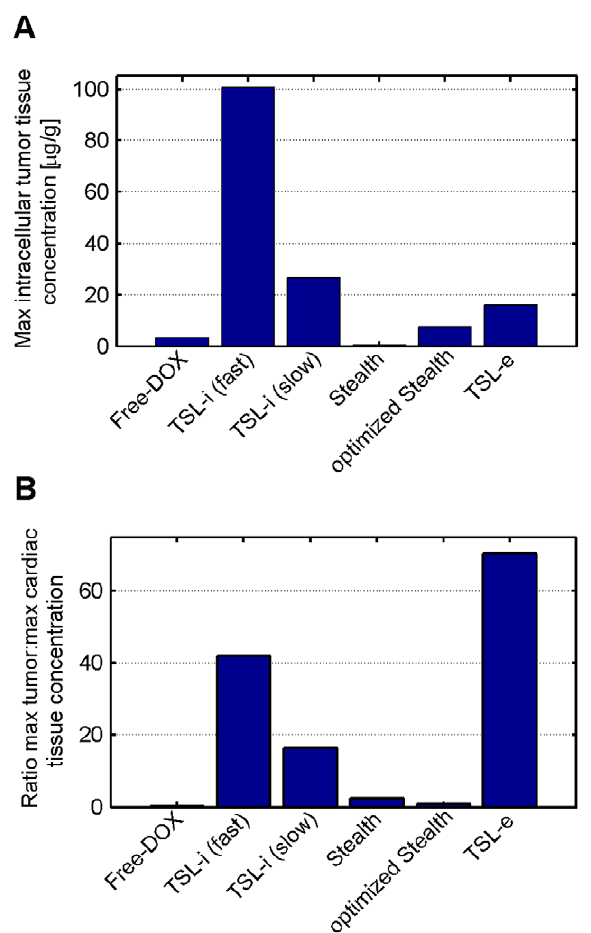
Figure 11. (A) Peak intracellular tumor tissue concentration of bioavailable DOX, and (B) ratio of peak bioavailable tumor tissue concentration to peak cardiac tissue concentration, presented for all DOX